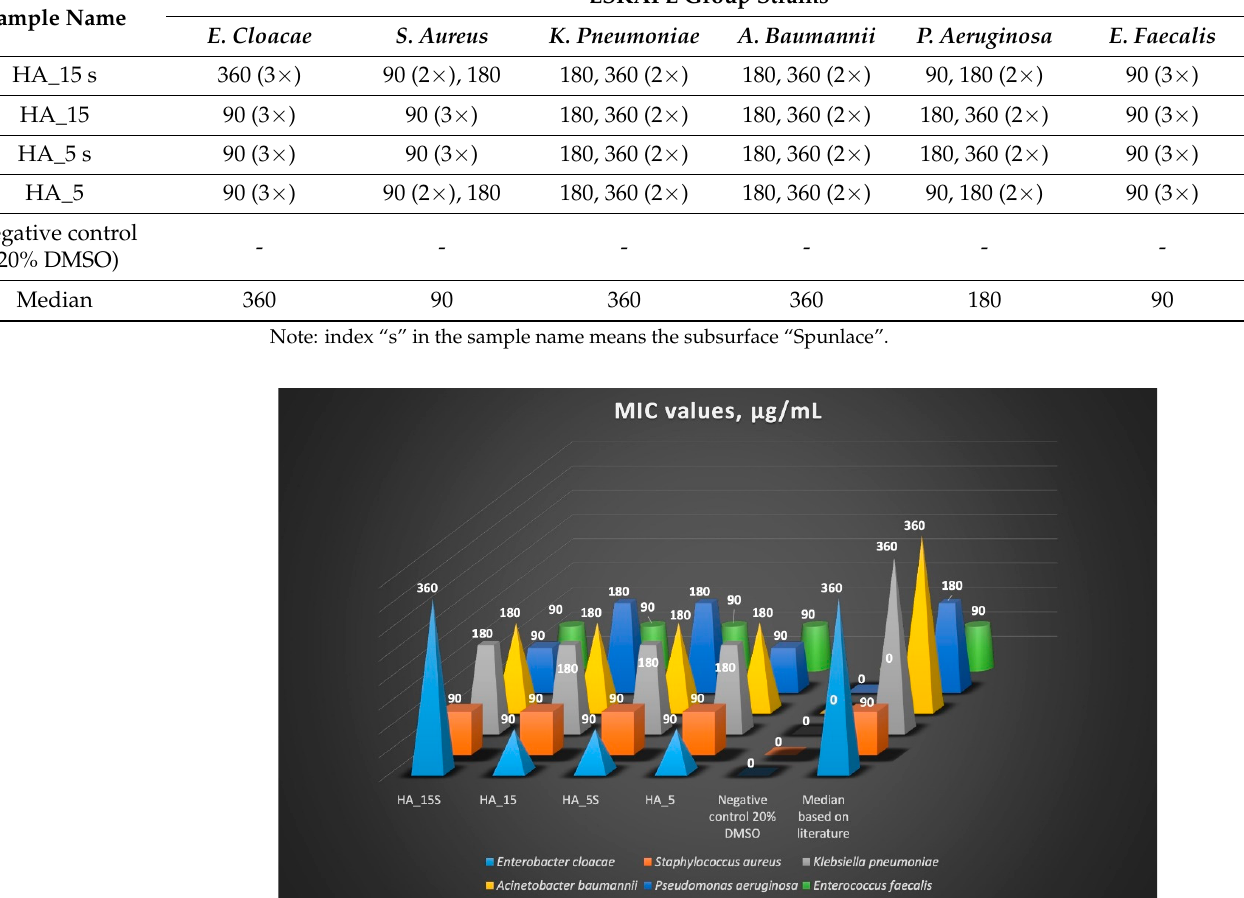
Table 8. Mean minimum inhibitory concentration (MIC) values ( μ g/mL).